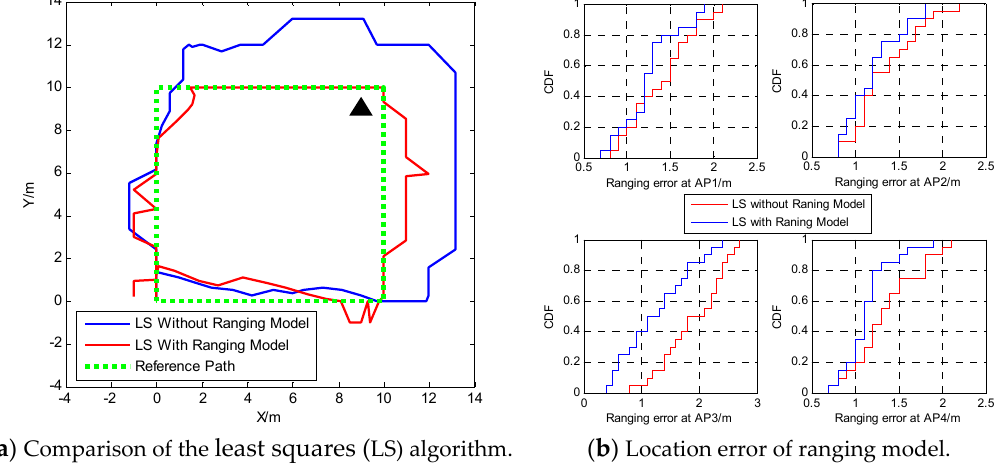
Figure 10. Estimation of Wi-Fi FTM-based ranging model.